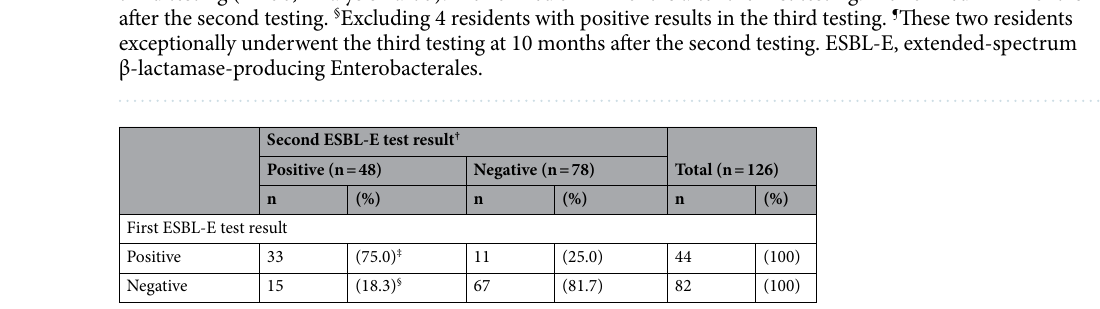
Table 4. Changes in ESBL-E carriage statuses from the first testing to second testing (n = 126; Analysis Part 2). ESBL-E, extended-spectrum β-lactamase-producing Enterobacteriaceae. † Performed 3–12 months after the first ESBL-E testing. ‡ 95% confidence interval: 59.4% to 86.3%. § 95% confidence interval: 10.9% to 28.7%. The 2.5th and 97.5th percentiles were used to express 95% confidence intervals.